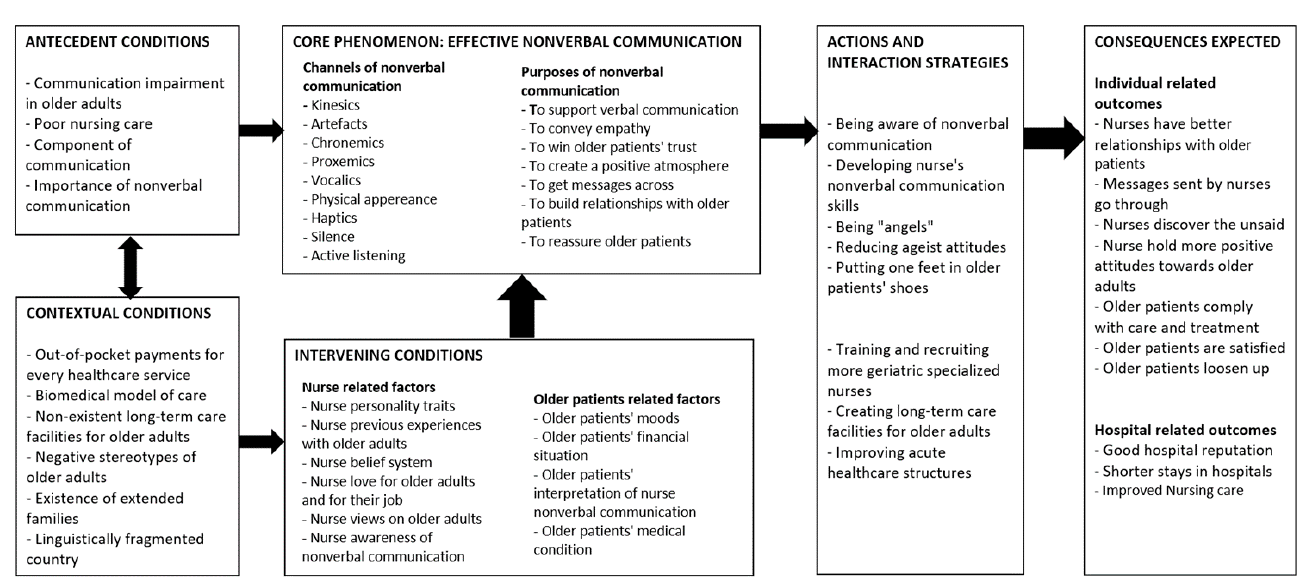
Figure 1. Summary of findings in line with Strauss and Corbin’s paradigm.